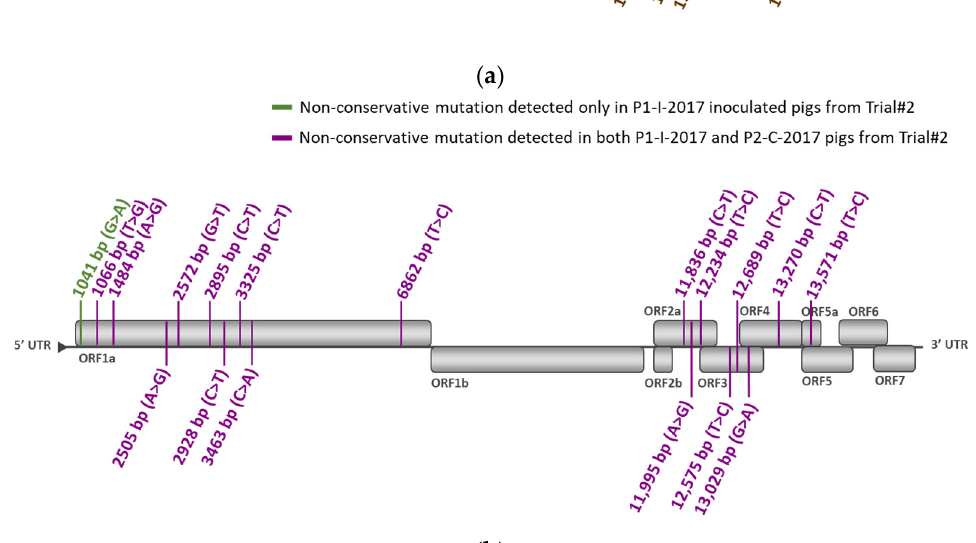
Figure 8. Localization in the PRRSV-1 genome of the identified non-conservative mutations occurred in P1-I-2012 and P2-C-2012 pigs during Trial#1 ( a ) or in P1-C-2017 and P2-C-2017 pigs during Trial#2 ( b ), using, respectively, the P0-2012 or the P0-2017 sequences as references. Mutation locations were indicated in the nucleotide sequence starting from the first nt of the 5 ′ nontranslated region (5 ′ NTR) on the KF991509.2 full-length sequence and the start codon of each open reading frame (ORF), respectively.